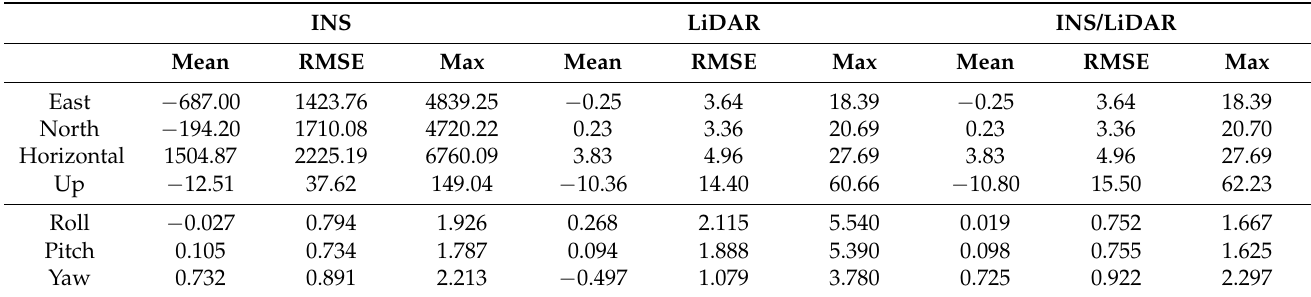
Table 6. D-28—GNSS-assisted—position (m) and attitude (deg) error statistics.